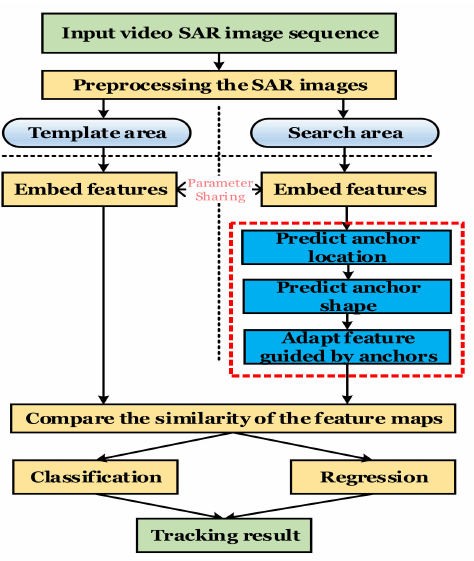
Figure 5. The whole process of arbitrary TOI tracking based on GASN. Step 1: Input Video-SAR image sequence.